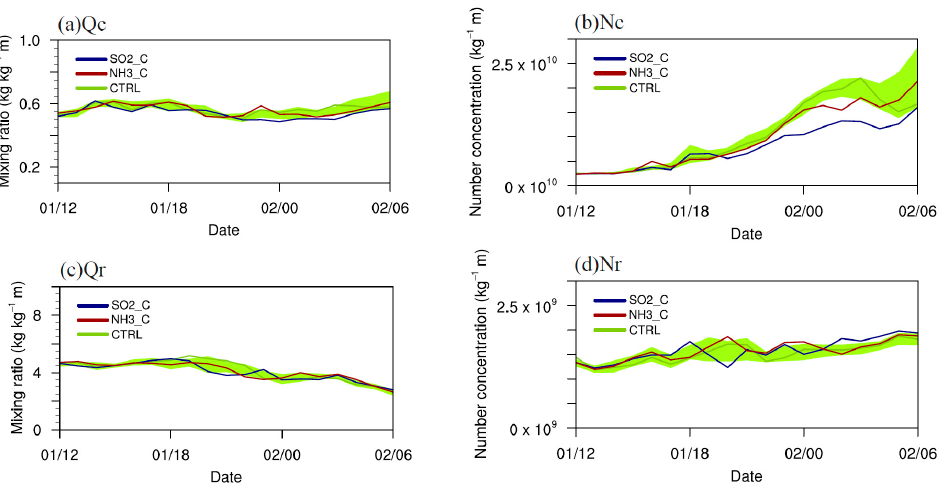
Figure 12. Area-averaged and vertically-integrated ( a , c ) mixing ratio (kg kg − 1 m) and ( b , d ) number concentration (kg − 1 m) of cloud droplets and raindrops within the radius of 150 km from the storm center. The shaded area in green presents the spread of ensembles.